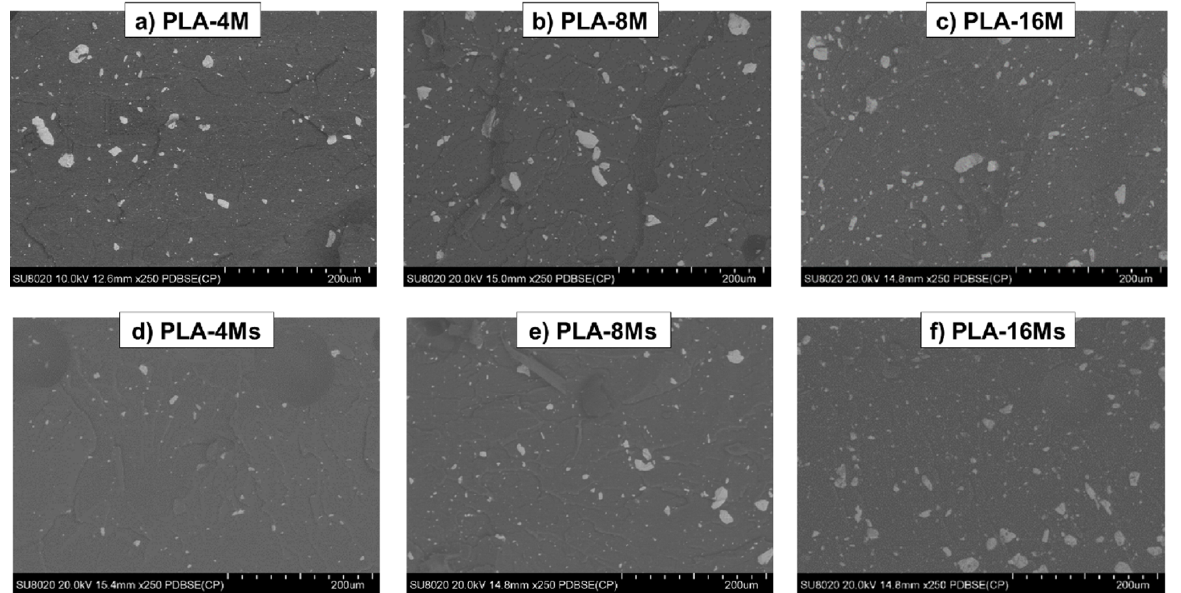
Figure 10. ( a – f ) SEM pictures of PLA–magnetite nanocomposites produced using untreated magnetite ( a – c ) and surface treated nanofiller ( d – f ).